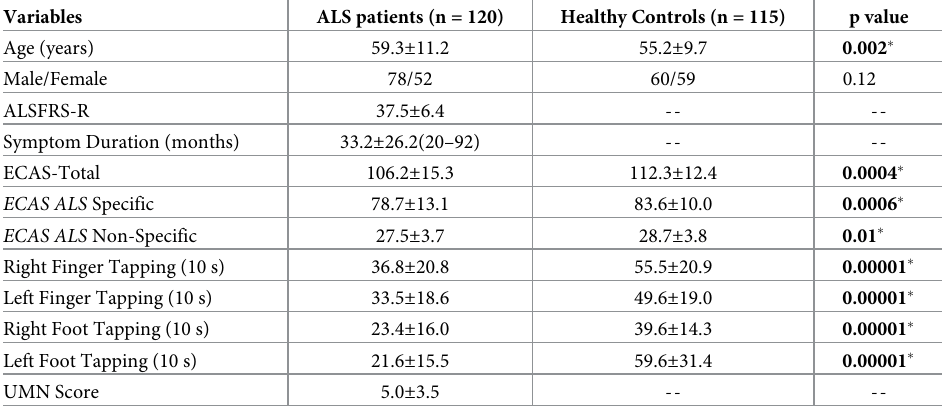
Table 2. Demographic and clinical features of ALS patients and healthy subjects.